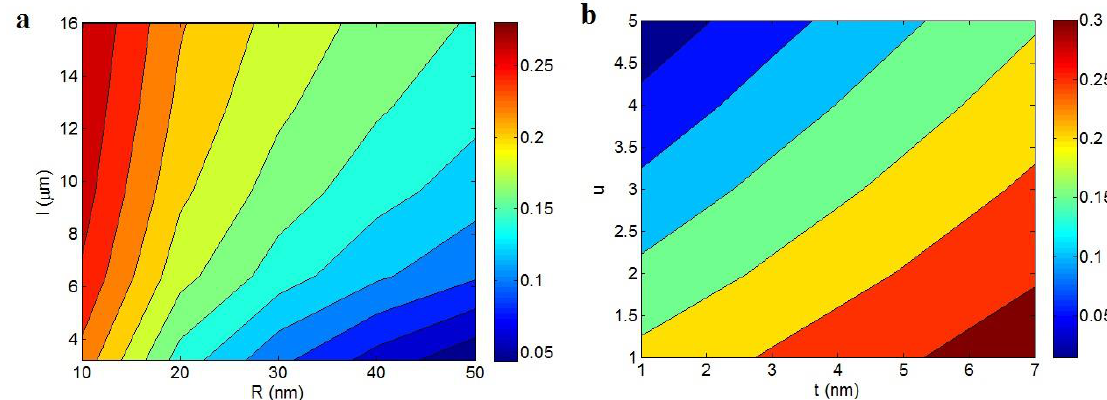
Figure 3. The variations of “f iu ” term at di ff erent levels of ( a ) “R” and “l” and ( b ) “t” and “u” parameters according to Equation (6).